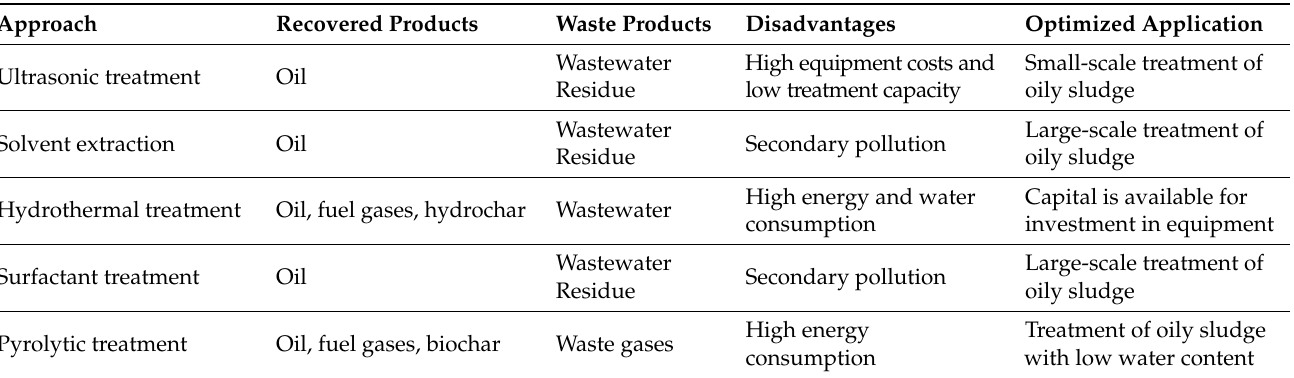
Table 3. A comparison of features among the five major valorization treatment approaches for oily